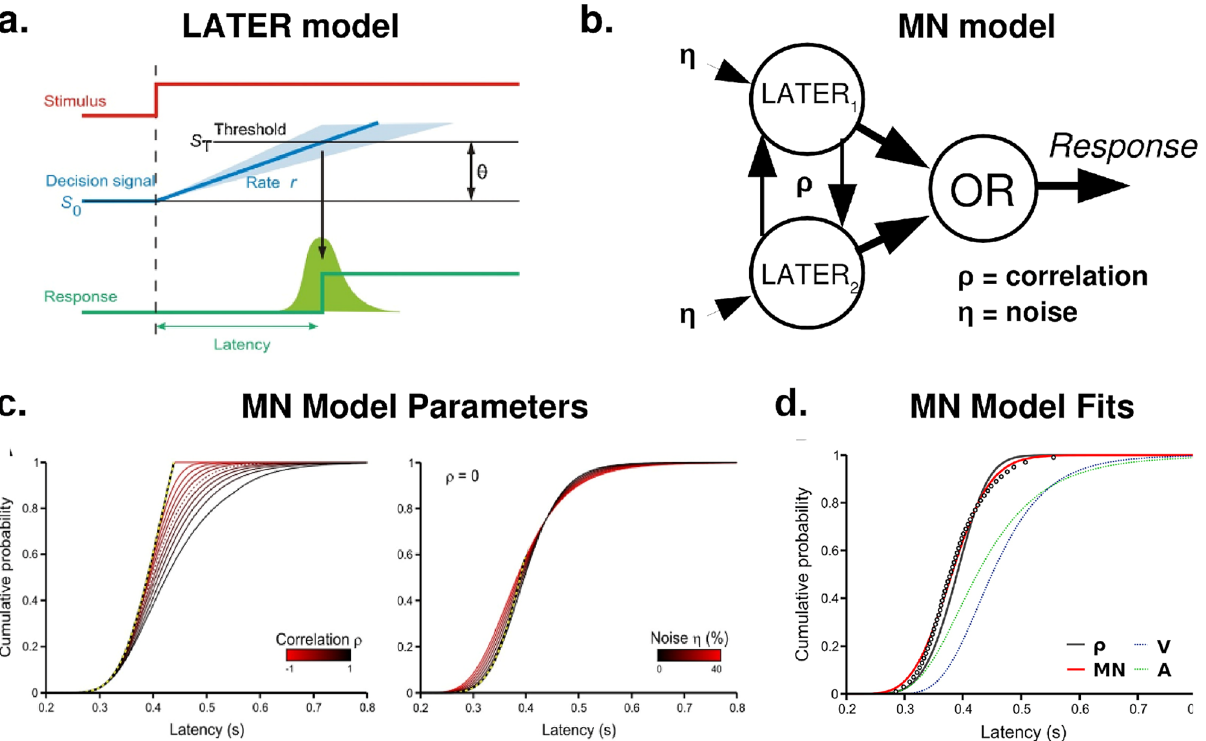
Figure 2. The LATER model 14 and its multisensory extension. ( a ) Schematic diagram of the (unisensory) LATER model. Evidence accumulation begins at S 0 and accumulates at rate r towards the response threshold S T . The rate parameter, r , is modelled as a normal distribution, resulting in a reciprocal normal (recinormal) reaction time distribution (green distribution), Θ/ N (μ,σ 2 ), where the distance-to-threshold parameter, Θ, is set to 1 by convention. ( b ) Schematic diagram of the multisensory noise (MN) model 9 . Two unisensory LATER models with correlation ρ and added noise η feed into an OR operator which triggers responses. ( c ) Effects of the ρ (left) and η (right) parameters on predicted cumulative RT distributions. Correlations primarily affect RTs towards the right end of the distribution, while added noise primarily influences RTs towards the left end of the distribution. ( d ) The MN model (red) with negative correlations and increased noise provides an excellent fit for empirical audiovisual RT distributions, surpassing the fit produced by accounting for intersensory correlations alone (ρ, black). Panel A modified with permission from 14 . Panels C and D modified with permission from 9